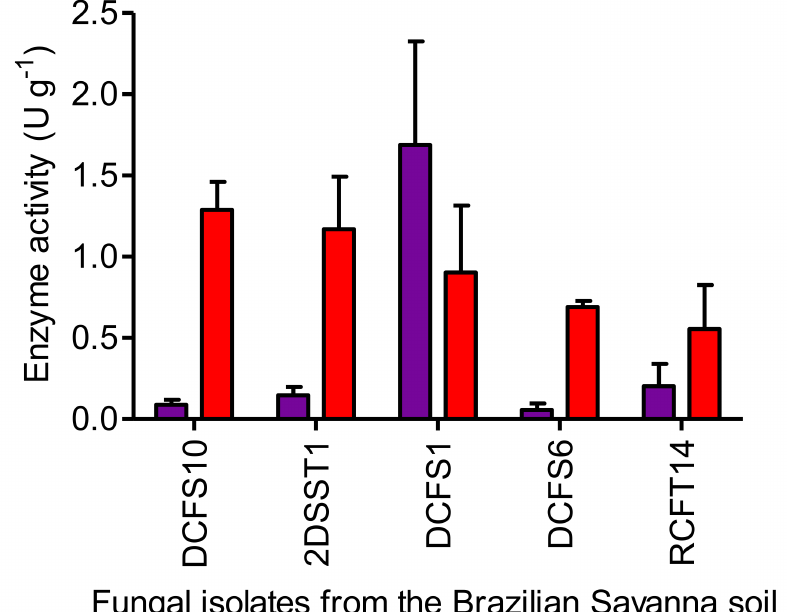
Figure 3. Distribution of enzyme activity quantified in the cells of fungal isolates from the Brazilian Savanna soil grown under submerged fermentation. Results are presented as mean ± standard deviation of enzyme activity. Red bar: L -asparaginase; purple bar: